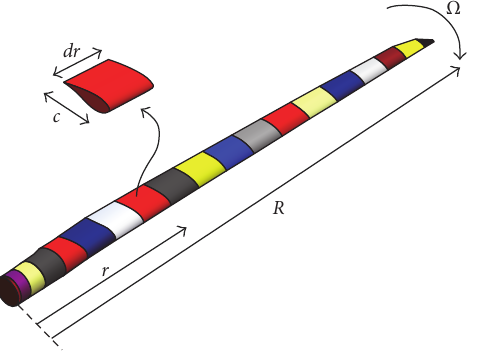
Figure 3: Typical aeroelastic tool principle.